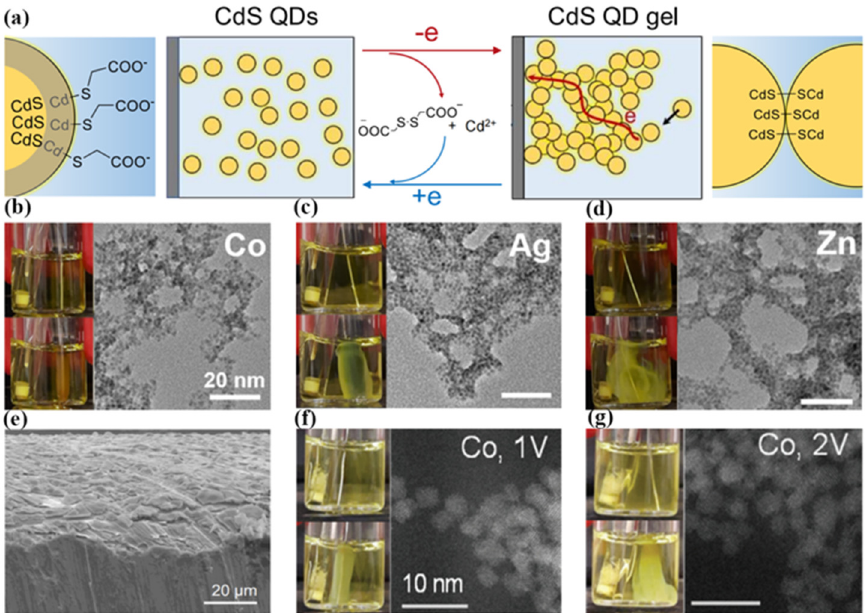
Figure 9. ( a ) Schematic diagram of QD self-assembly by the electrochemical method. ( b – d ) Metal ion-mediated electrogelation-gelation of CdS QDs using different metal anodes Co, Ag, and Zn, respectively. ( e ) SEM image of the CdS QDs gels grown on a Ni foil electrode surface [58]. Copyright 2021, Chemistry of Materials. ( f , g ) Photographs and STEM micrographs of the QDs gels produced using Co electrodes at 1 V and 2 V [59]. Copyright 2021, Nanoscale .